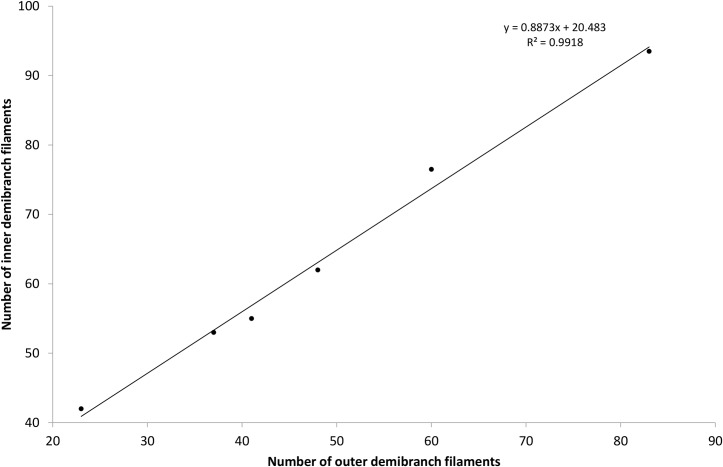
Scatter plot of the number of inner ‘vs’ outer demibranch filaments.The number of inner demibranch filaments is able to predict the number of outer demibranch filaments and accounted for 99% of the explained variability in number of outer demibranch filaments.